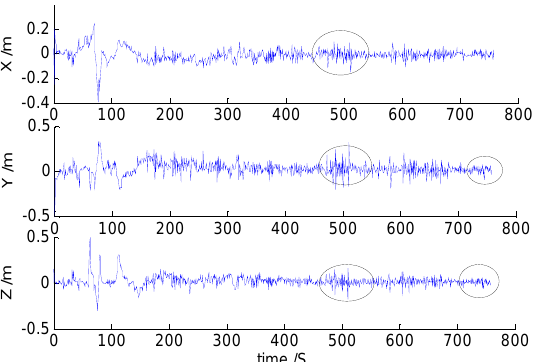
Figure 4. The position error of SVD-RCKF (  = 1) in case 1